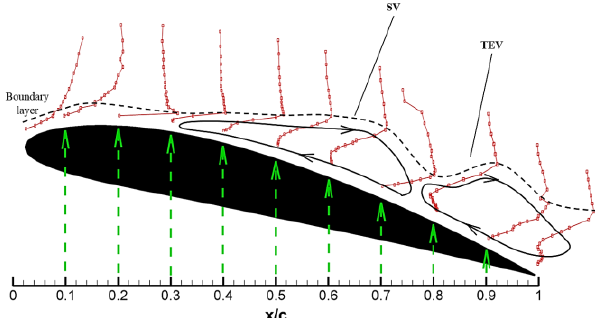
Fig. 4. u/U velocity profile in the boundary layer of NACA 4412 airfoil .